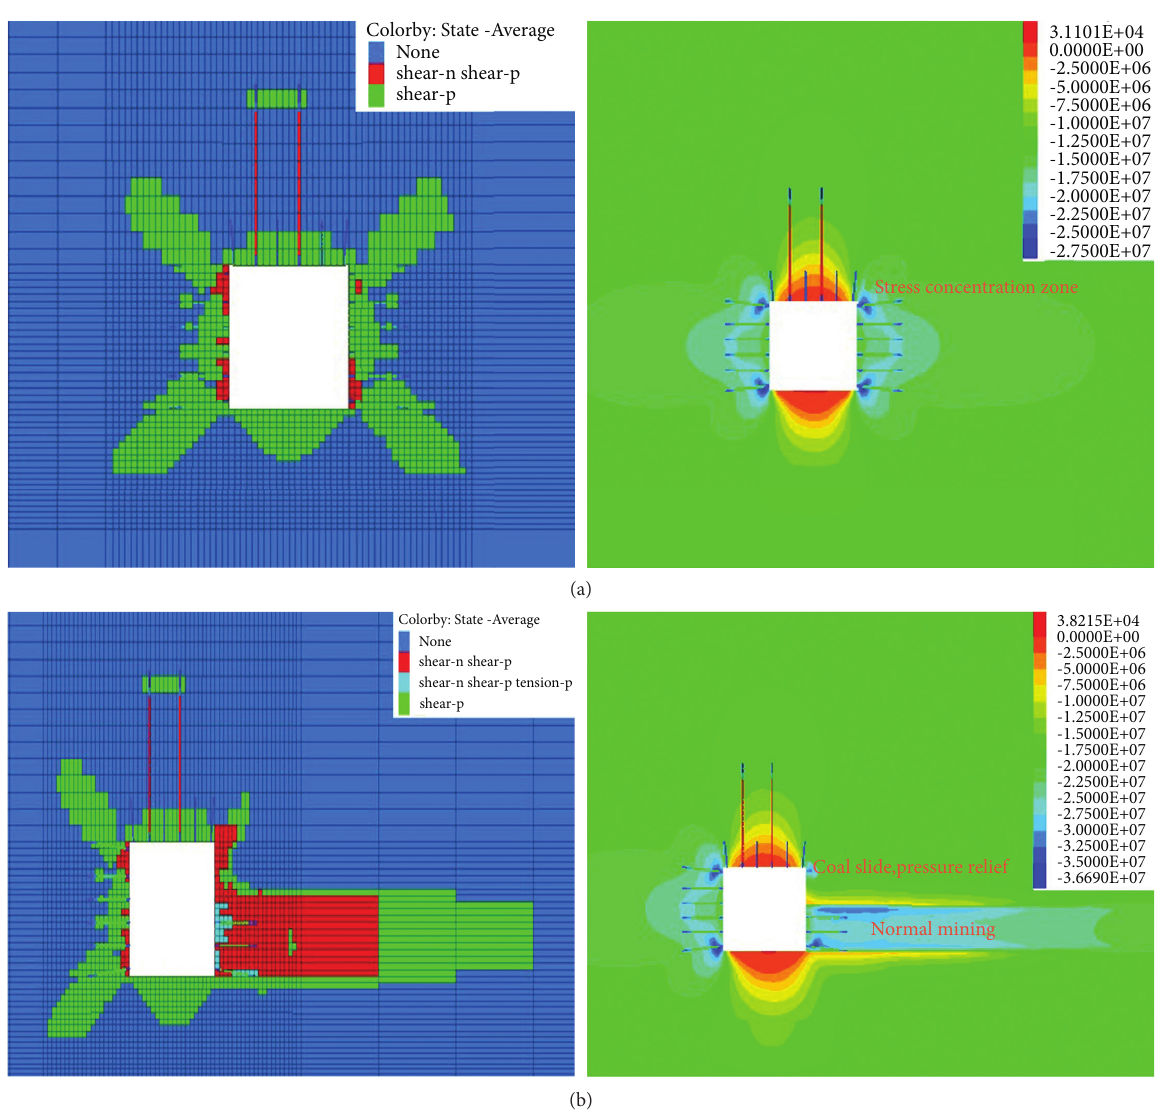
Figure 5: Distribution of the plastic zone and stress of surrounding rocks at the top corner of the end before and after mining: (a) stress distribution of roadway surrounding rocks without mining; (b) stress distribution of roadway surrounding rocks after mining.